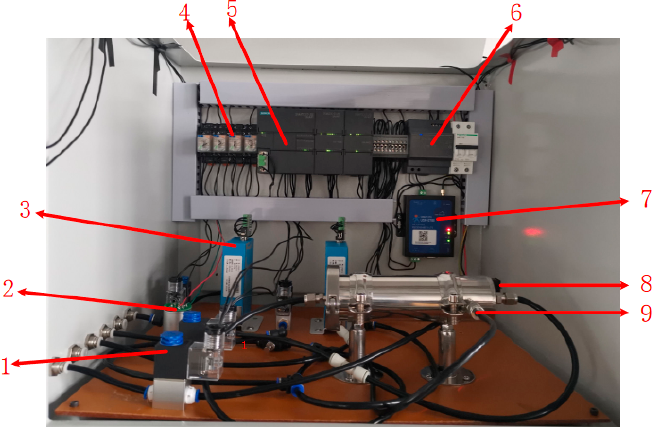
Figure 11. Physical implementation of the gas distribution system. 1. Solenoid valve; 2. CO 2 sensor; 3. mass flow controller; 4. relay; 5. PLC; 6. power switch; 7. 4G DTU; 8. power supply socket; and 9. gas mixture.